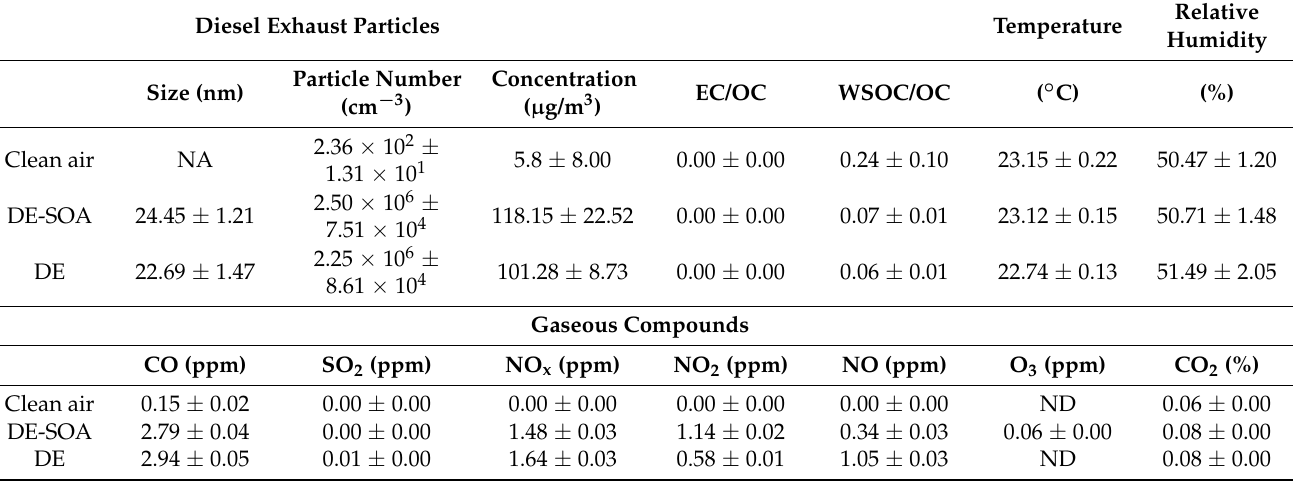
Table 2. Particles and gaseous compounds in the exposure